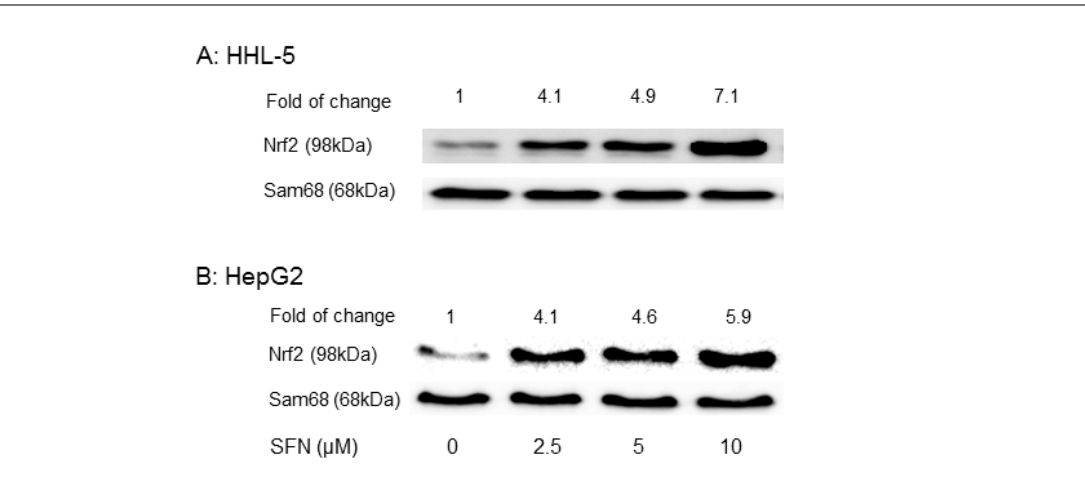
Fig. 3. Effect of SFN on translocation of Nrf2 into cell nucleus. Nrf2 was detected in nuclear extracts from cells exposed to SFN (0, 2.5, 5 and 10 m M) for 24 h, using a Western blot assay. Control cells were treated with DMSO (0.1%). A: immortalised human hepatocyte HHL-5; B: human heptoma HepG2 cells.